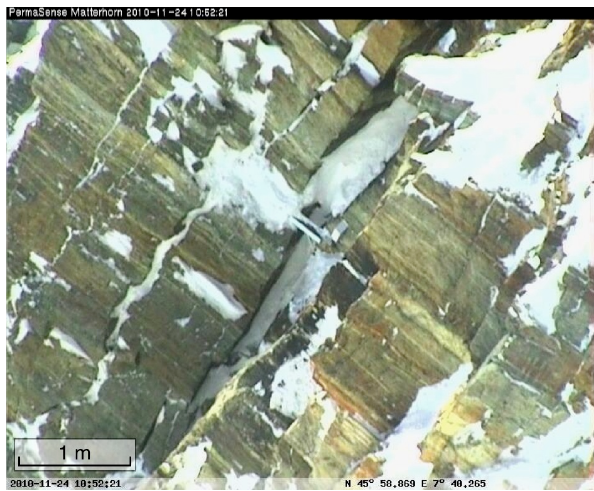
Fig. 5. Fractures with large spacing and aperture at Matterhorn H¨ornligrat (pict. from November